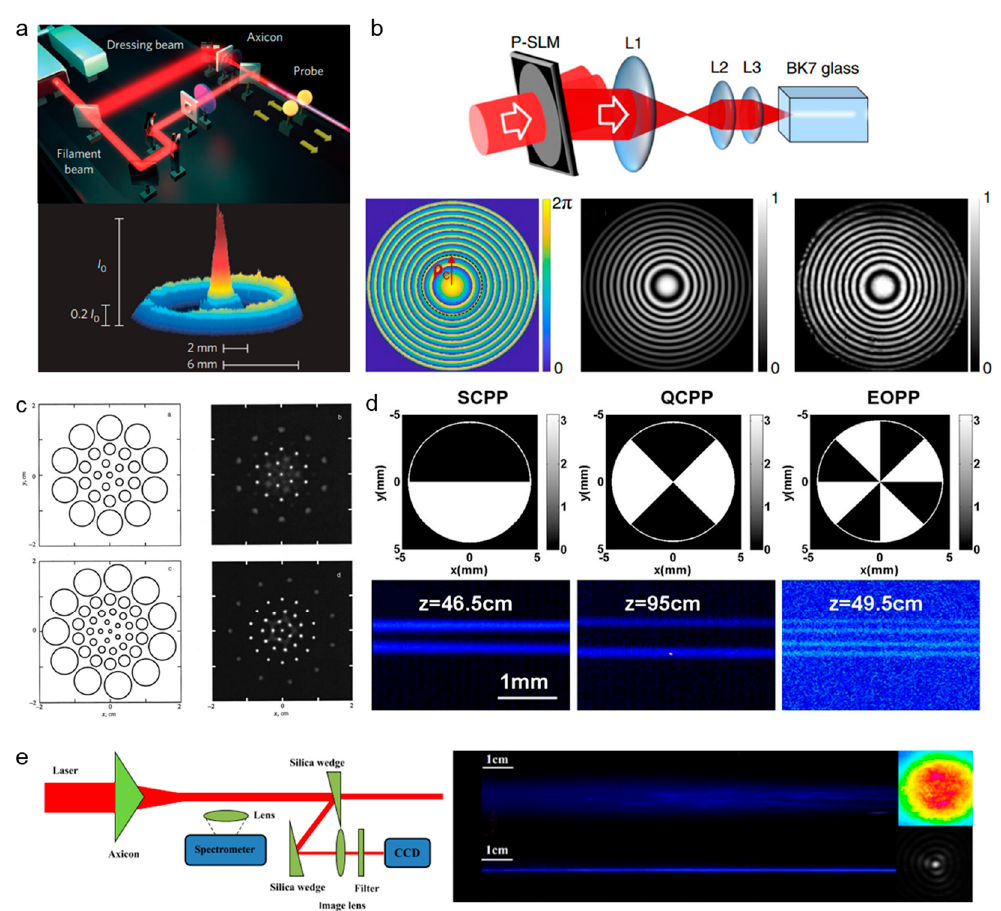
Figure 9. Controlling of multiple filaments by ( a ) an auxiliary beam [148], ( b ) phase-only spatial light modulator (P-SLM) [153], ( c ) lens array (left: lens arrays; right: the filaments that were formed by corresponding arrays) [155], ( d ) phase plates (SCPP, semicircular phase plate; QCPP, quarter-circle phase plate; EOPP, eight-octant phase plate) [157], ( e ) axicon [146].